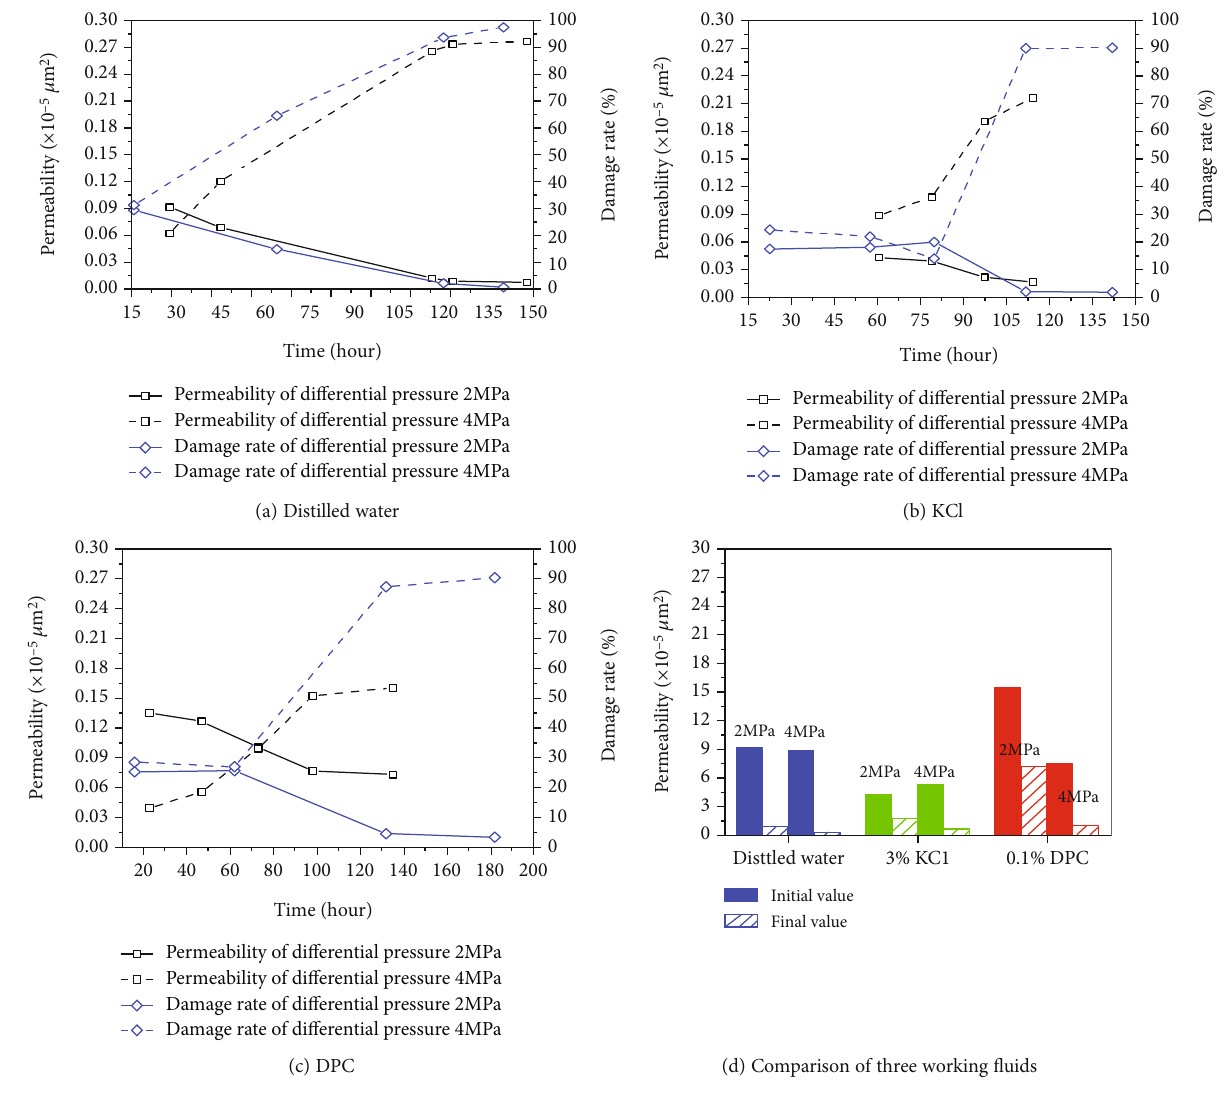
Figure 9: E ff ect of permeability damage rate under di ff erent pollution pressure di ff erences.